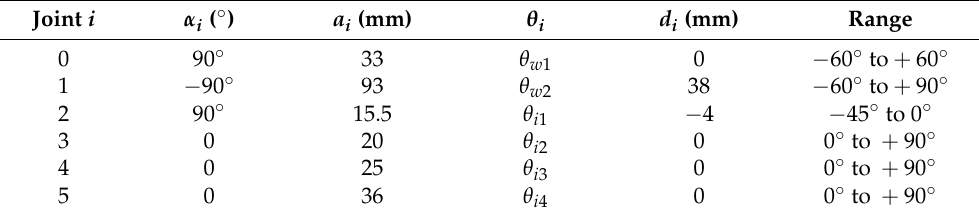
Table 1. Denavit and Hatenberg (D–H) table of the index finger.